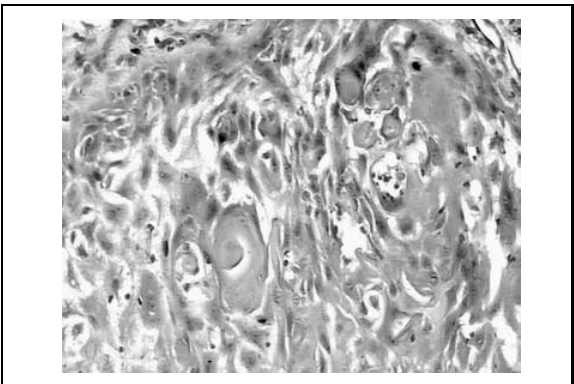
Figure 4 – Photomicrograph of the ghost cells and other neoplasic cells (H&E, x 200)